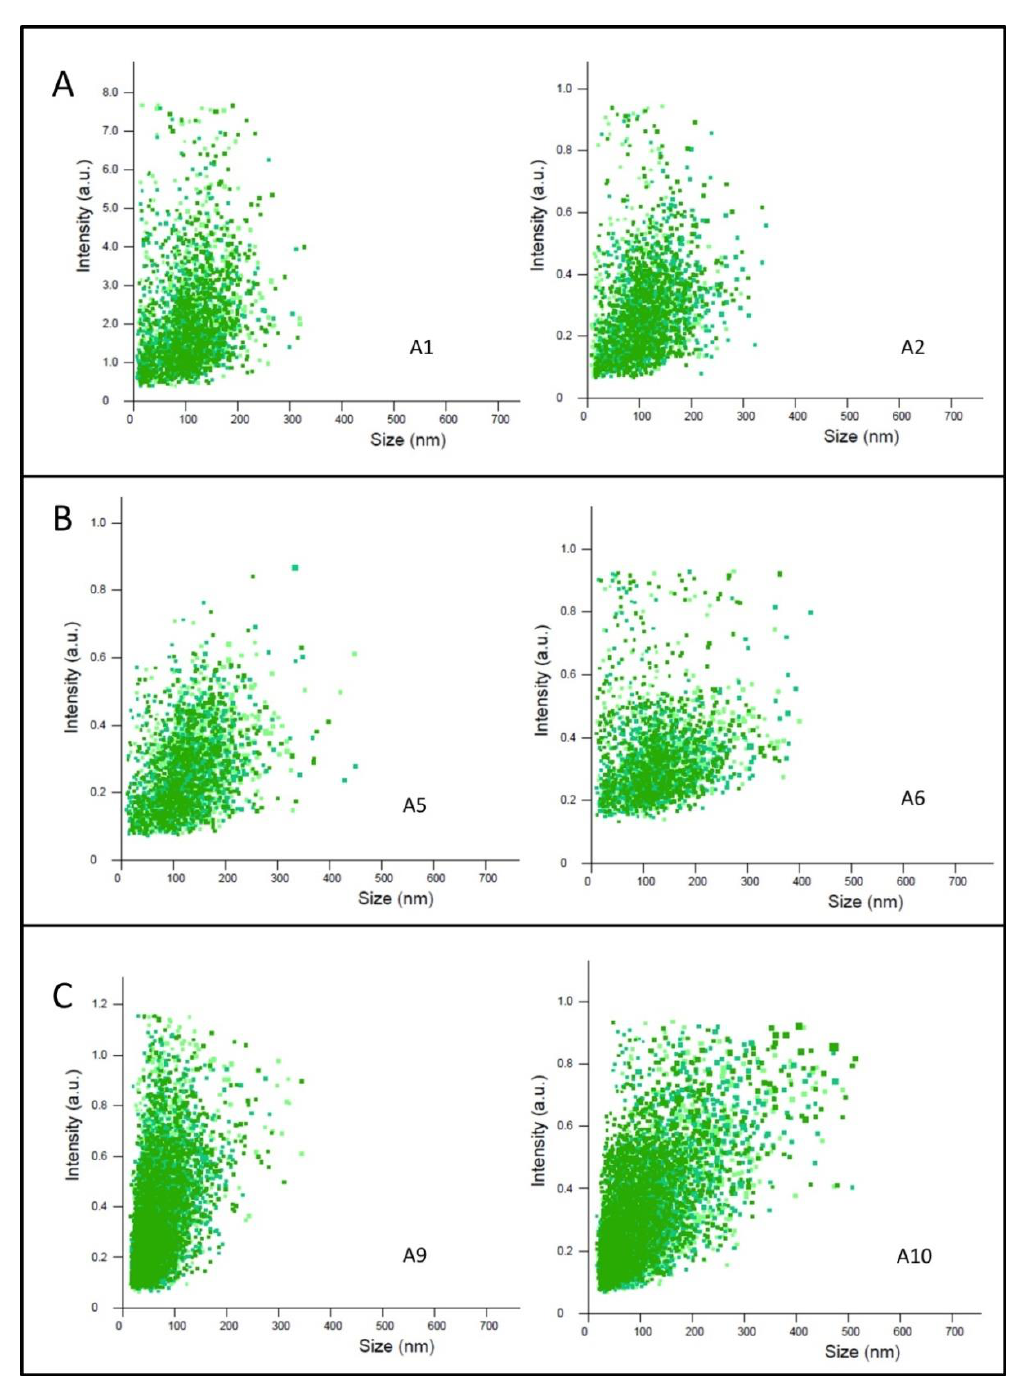
Figure 2. Effects of TQ loading and TFR on nanoparticle size distribution of selected continuously produced TQ-free and TQ-loaded nanodispersions and two nanodispersions prepared using a batch method. 2D plots of relative light-scattering intensities of TQ-free and TQ-loaded citrem/SPC nanoparticles versus nanoparticle sizes are presented. In microfluidic synthesis, all nanodispersions (samples A1, A2, A5, and A6) were prepared at a constant FRR of 20 and two TFRs of 100 and 50 min, respectively. 2D plots of TQ-free (samples A1 and A2) and TQ-loaded (samples A5 and A6) are presented, respectively, in panels ( A , B ); whereas panel ( C ) shows the 2D plots of corresponding TQ-free and TQ-loaded nanodisper- sions (samples A9 and A10) prepared using the low energy-emulsification batch method. All nanodispersions were pre- pared at citrem/SPC weight ratio of 2:3 and constant EtOH and lipid (SPC plus citrem) concentrations of 2.86 and 1.9 wt%, respectively. TQ-loaded samples were prepared at a constant TQ concentration of 2.5 mg/mL.